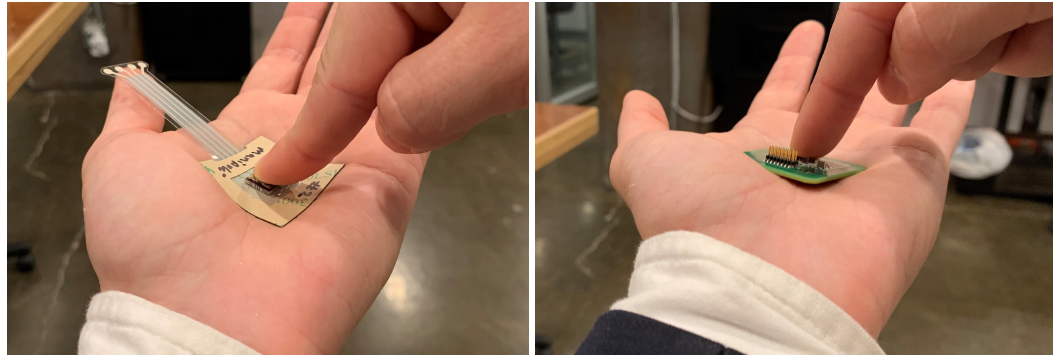
Figure 7. Electrode conformability comparison: ( left ) hybrid flexible electrode. ( right ) Rigid electrode.